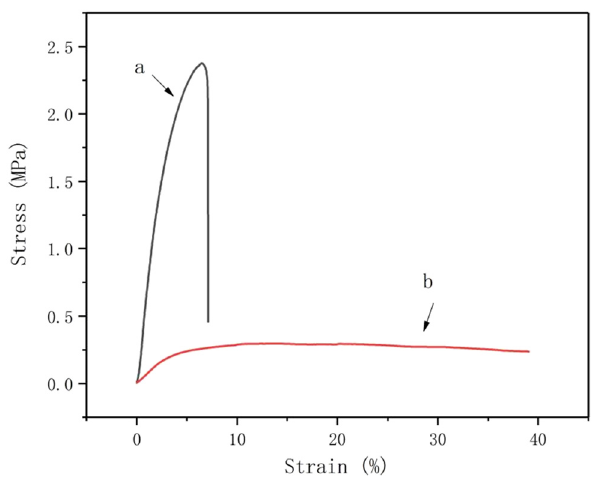
Figure 7: CV curves at di ff erent scanning speeds.